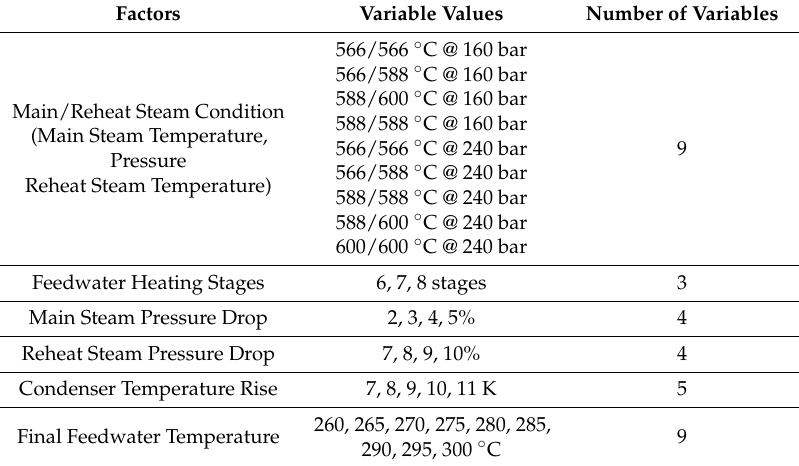
Table 2. Simulation input